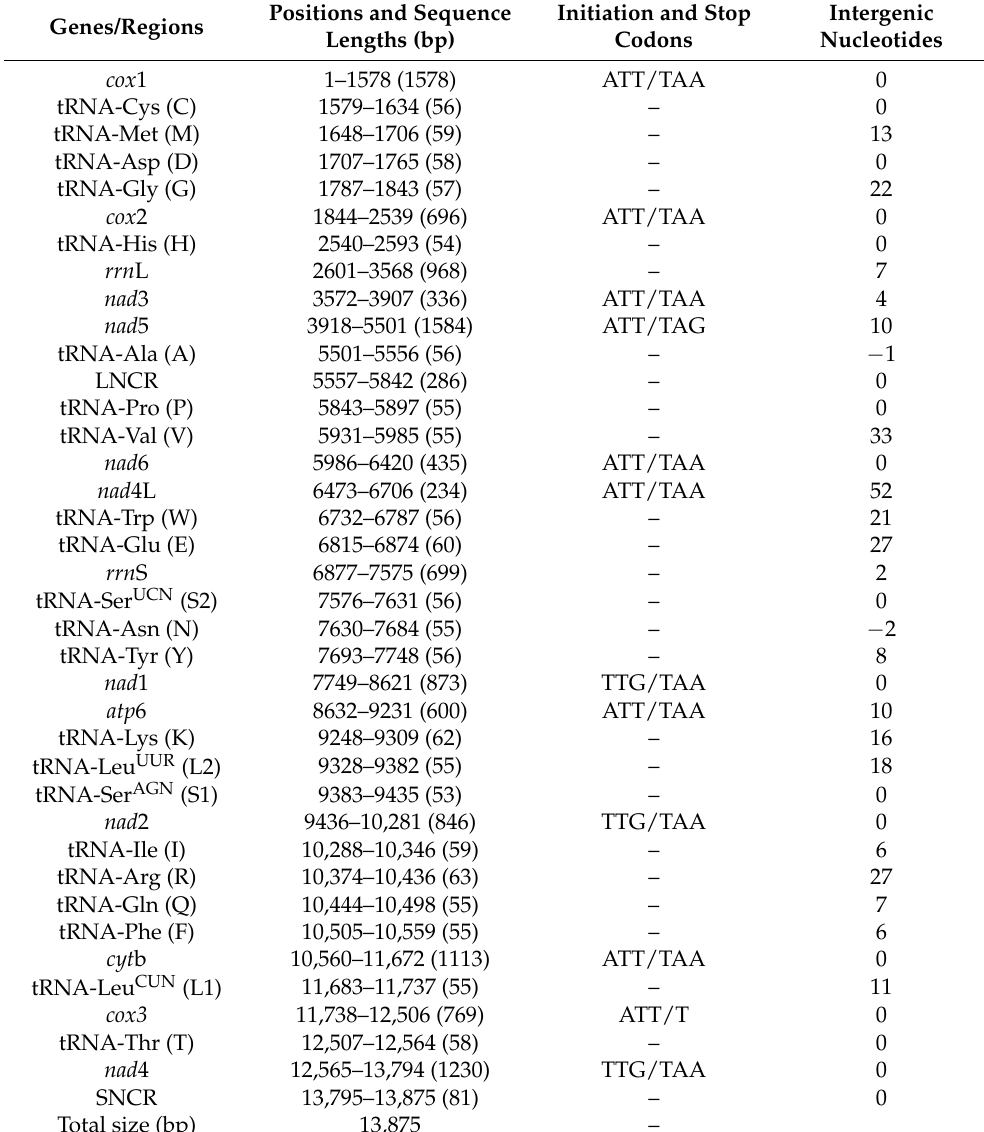
Table 1. The gene composition, position, codons, and spacer/overlap regions of complete mt genome of C. elongatus